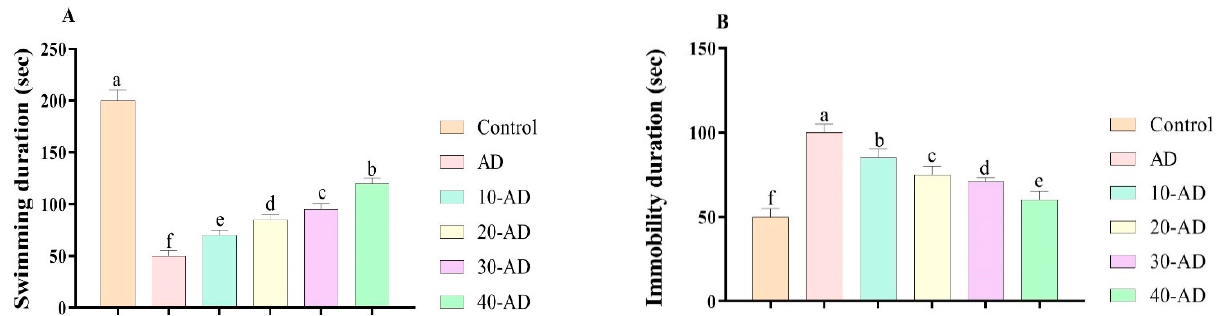
Figure 3. The effects of sake yeast on depression-like behavior in rats with Alzheimer. (A) Swim- ming duration and (B) Immobility duration. Superscript symbols (a–f) show significant differences between groups.